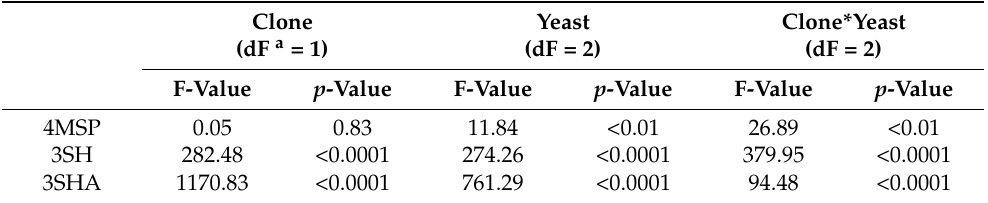
Table 2. Summary of F - and p -values of ANOVA for clone and yeast effects and clone*yeast interac- tions on varietal thiols in wine.